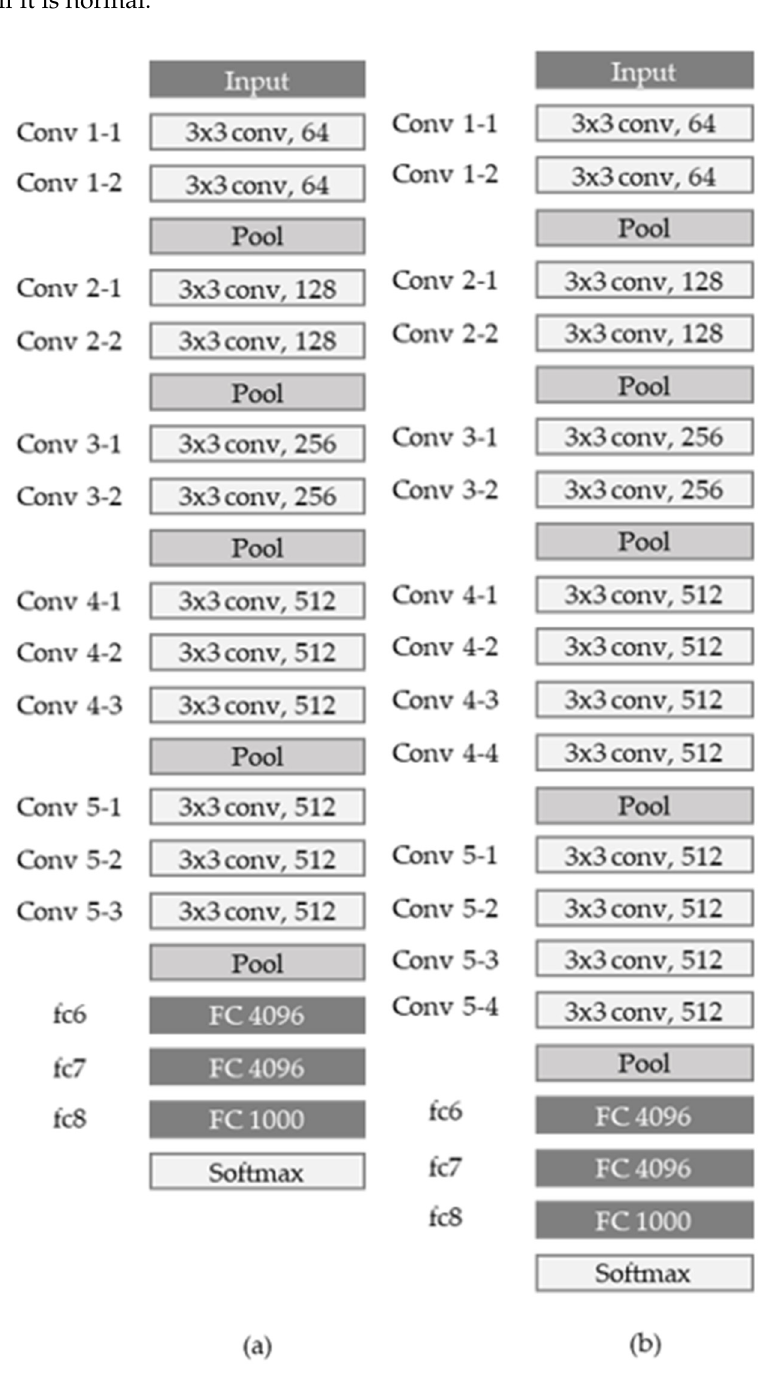
Figure 1. ( a ) Architecture of the VGG16 network; ( b ) Architecture of the VGG19 network.